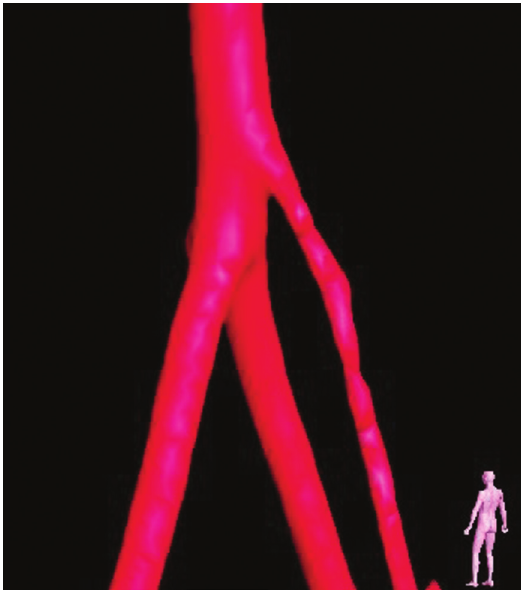
Figure 3 - The reconstruction of images by volume rendering enables determination of the three-dimensional characteristics of the arterial tree, including diameter, angle of bifurcation, and other